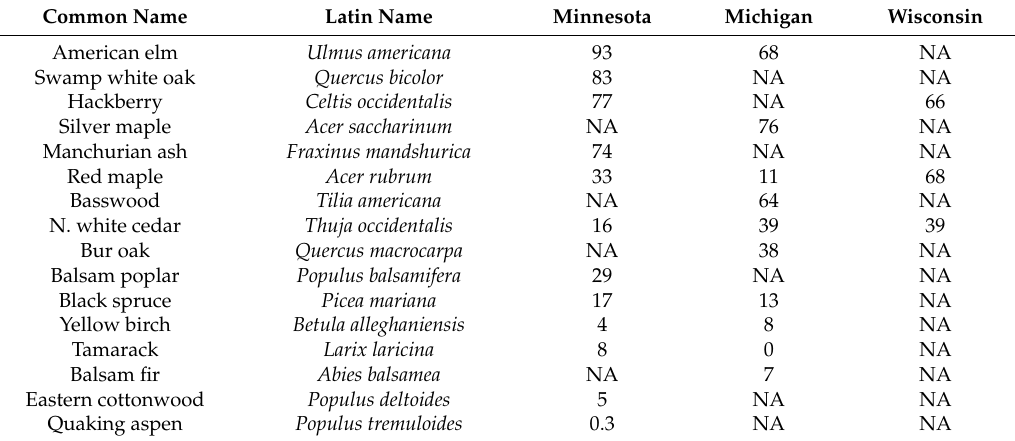
Table 1. Mean under planting survivability (%) after three growing seasons from three planting studies in uninfested black ash wetlands. Minnesota results [10] are the mean values from the control stands and the Michigan and Wisconsin results [32] are from the hummock planting locations. NA is not applicable, as those species were not planted in the individual